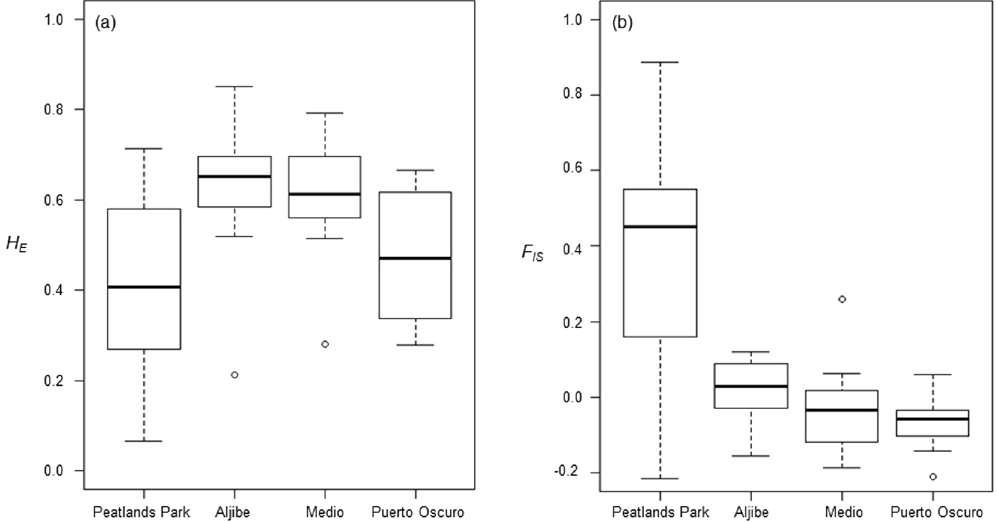
Figure 3. Boxplots showing values of ( a ) H E , and ( b ) F IS in the Peatlands Park population analyzed in the present study and three Spanish populations analyzed in Riguiero et al . (2009).